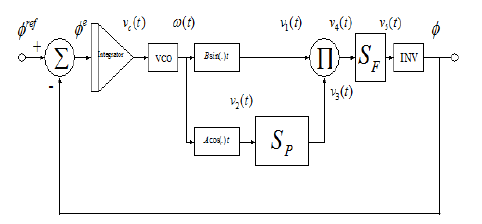
Fig.5. Phase-locked loop